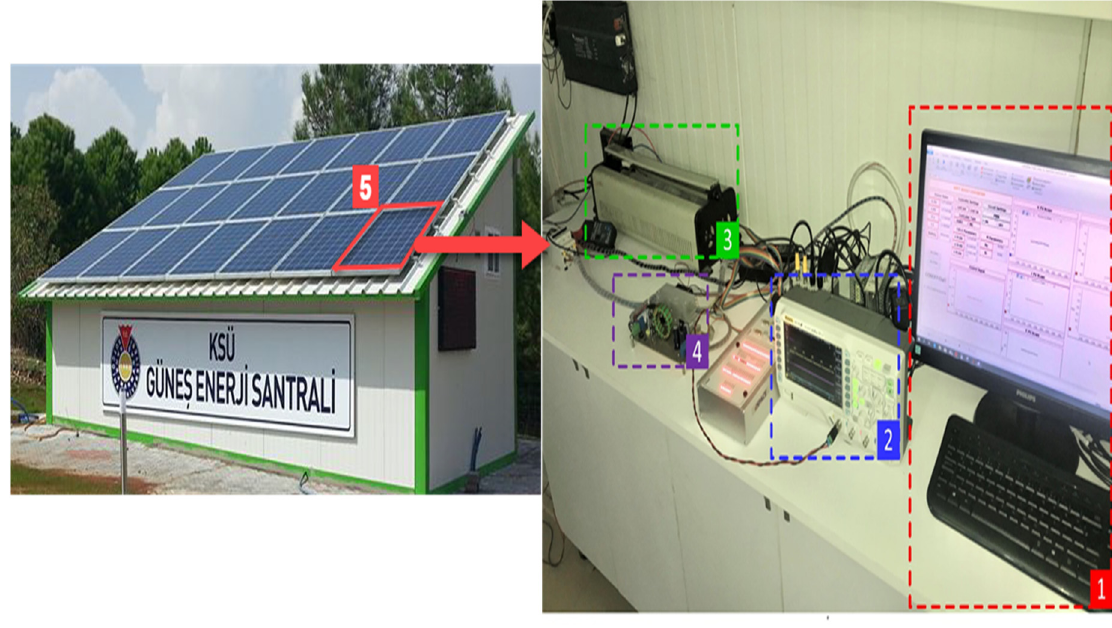
Figure 12. Experimental setup of MPPT based on AIC- IT2-TSK-FLC.